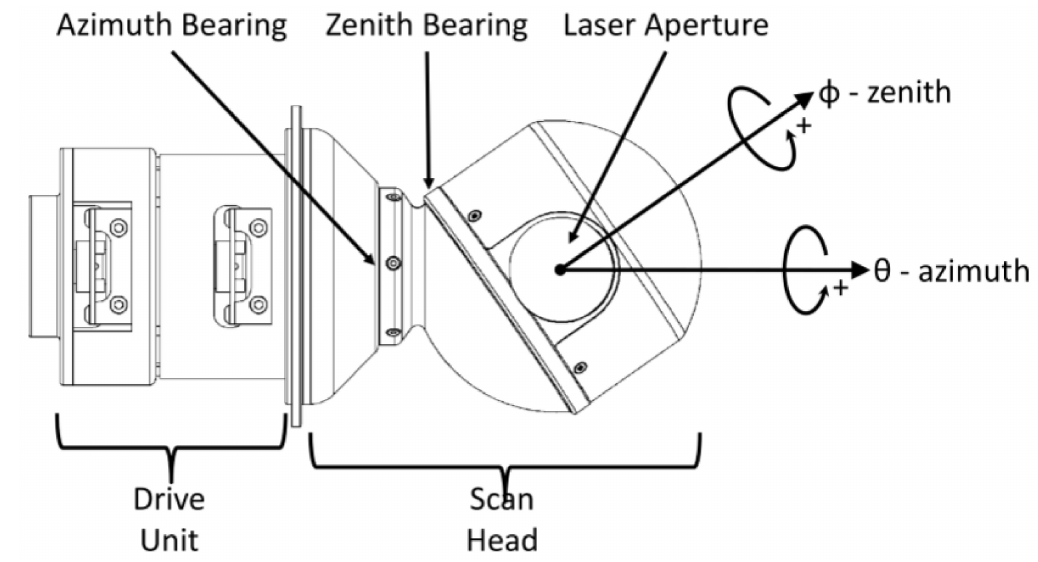
Figure 9. Illustration of 3D LiDAR scanner using gyroscopic mirrors [19].